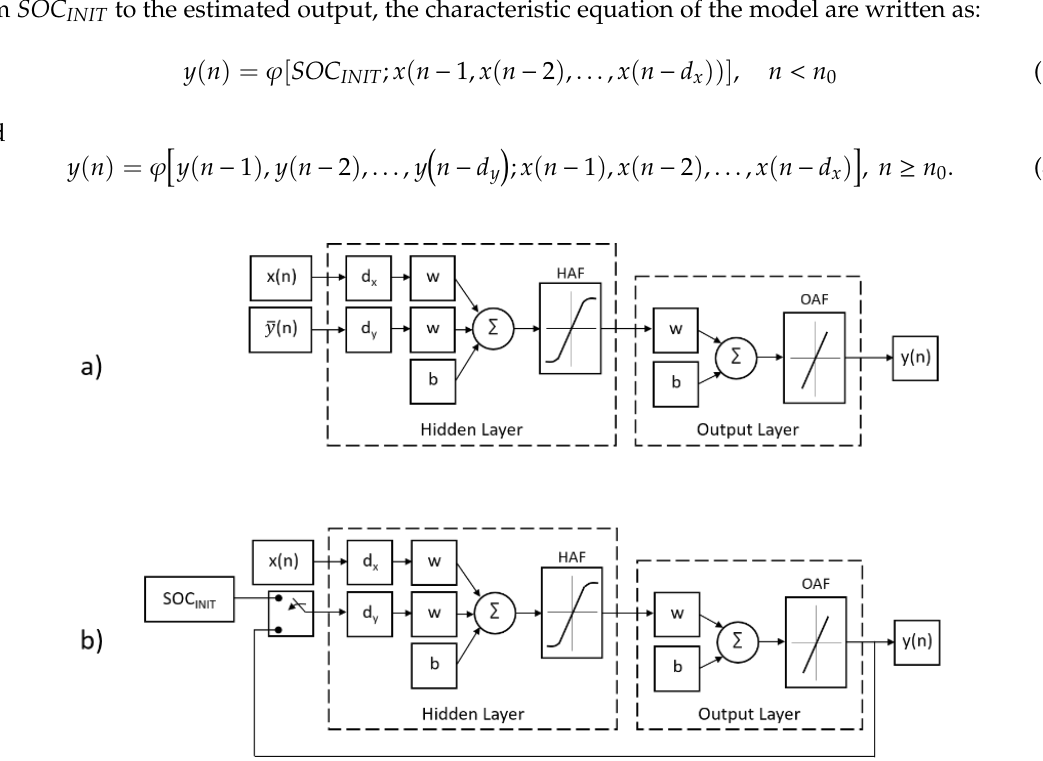
Figure 3 . NARX architecture. ( a ) Series-Parallel (SP) mode (open-loop configuration) for training. ( b ) Parallel (P) mode (closed-loop configuration) for estimation.